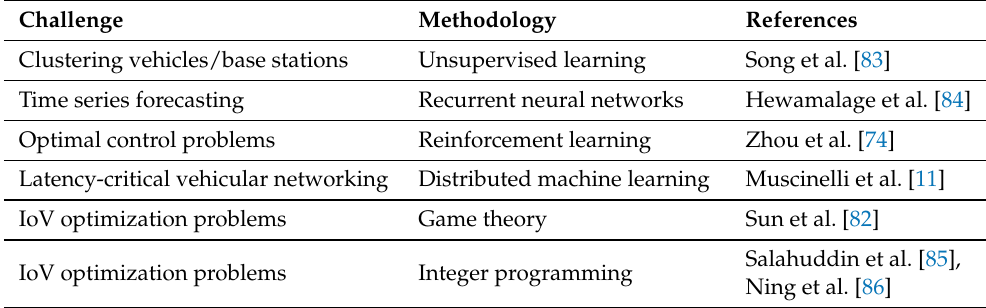
Table 1. Main challenges and methodologies